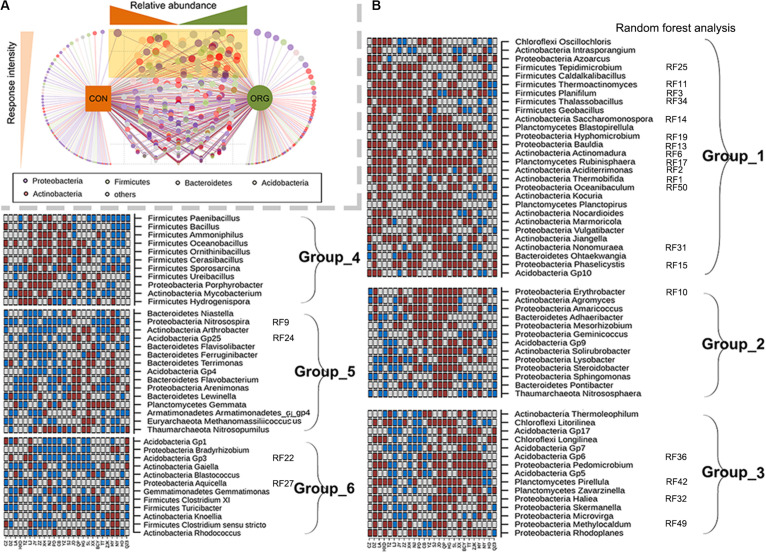
Bacterial genera with significantly (p < 0.05) different relative abundances between farming systems and their association with different soil physicochemical properties. (A) The frequency of a genus to be discriminative between farming systems. The light yellow triangle indicates an increased frequency of a genus to be discriminative between farming systems. (B) Groups of genera with similar response patterns to farming systems and which ranked in the 50 most influential genera across sites; ORG, organic farming system; CON, conventional farming system. Brown and cyan squares indicate significantly (p < 0.05) higher or lower relative abundance in the ORG than in the CON, respectively. Gray squares indicate no significant difference between farming systems.